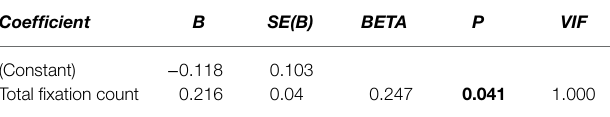
TABLE 13 | Linear regression between ECL and total fixation count ( n =